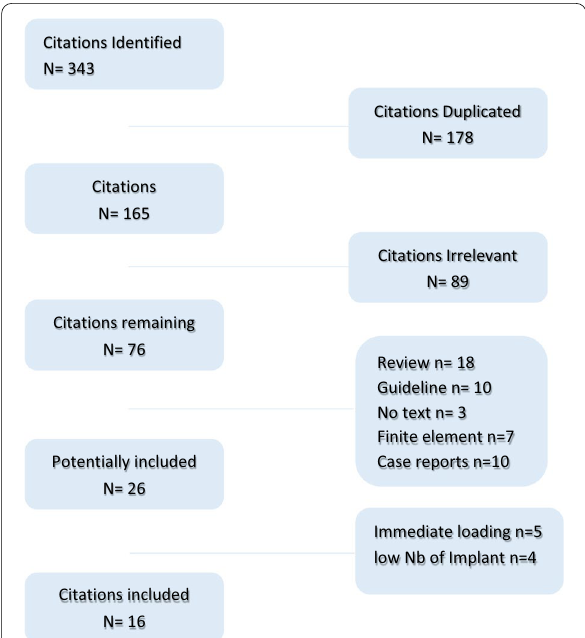
Fig. 1 Flow chart for review of literature searches included in the current study